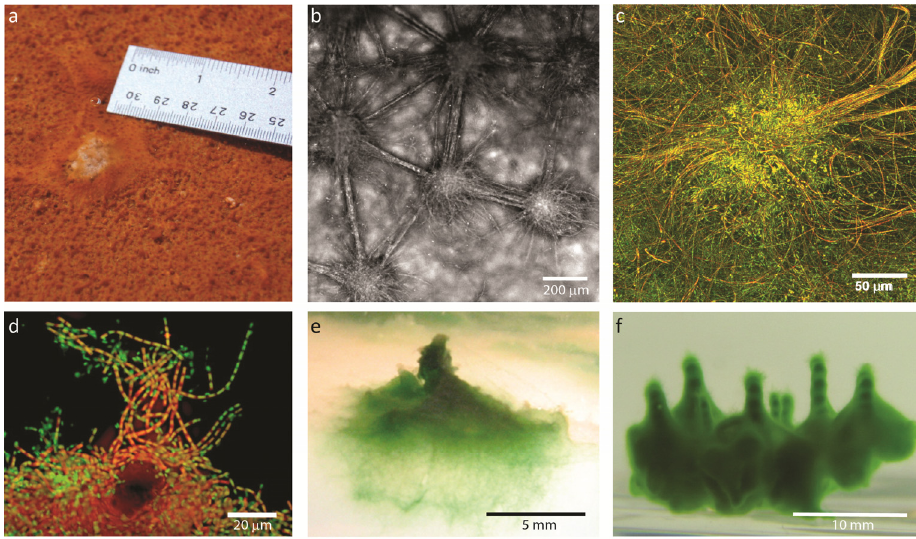
Figure 1. Morphogenesis of modern cone-forming cyanobacterial mats. ( a ) Photograph of mm-scale clumps that nucleate cones in Yellowstone National Park. The bottom scale on the ruler is numbered in cm; ( b ) Epifluorescence micrograph of a laboratory-grown mat showing clumps surrounded by flat areas and bundles of aligned filaments bridging the clumps; ( c ) Confocal epifluorescence micrograph of a clump. Red areas in ( c ) and ( d ) show Chl a autofluorescence. Green fluorescence tracks the presence of DNA stained by Sytox ® Green (Invitrogen, Carlsbad, CA, USA); ( d ) Epifluorescence micrograph showing vertical and three-dimensionally bent filaments at the tip of a small cone. This cone nucleated from a clump; ( e ) Cone that grew in the laboratory from a small clump. The clump was placed on agar illuminated from below and the culture vessel was shielded from the light on all other sides. Some filaments migrated into the agar toward the light source, but most aggregated into the dense small cone. This experiment shows that the vertical aggregation of cone-forming cyanobacteria does not require migration toward light; ( f ) Internally laminated cyanobacterial cones with tufted tips and darker, clumped regions. Both the porous laminae of small cones and the clumped regions contain bent and bowed